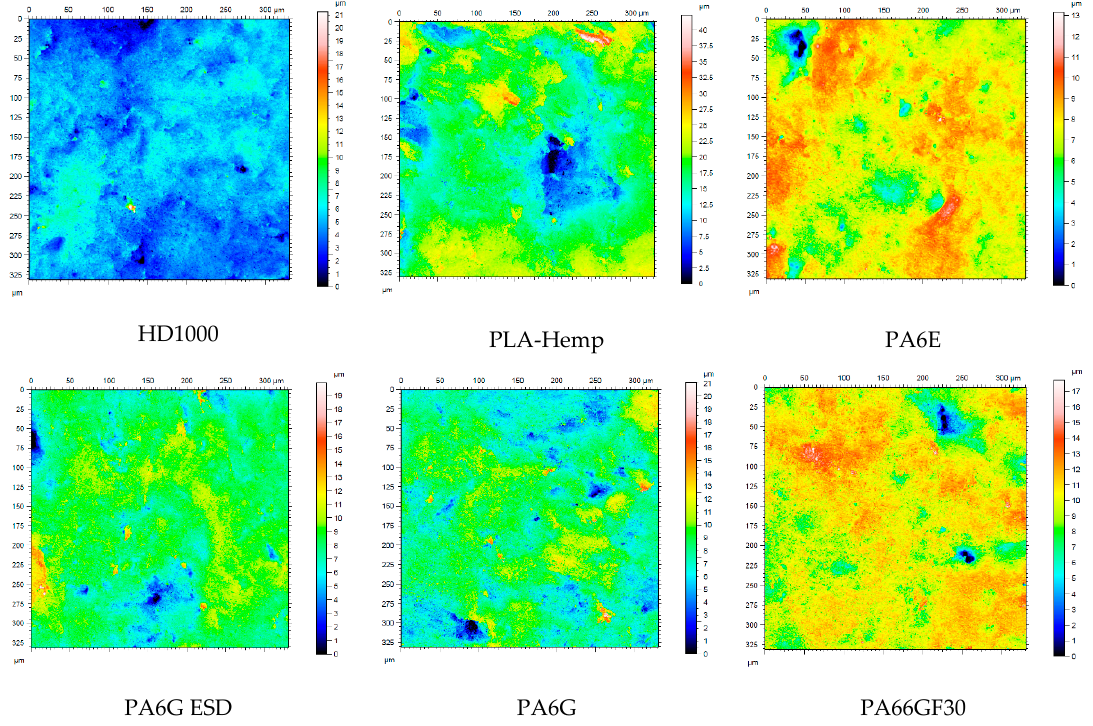
Figure 15. Microscopic visualization of the change of surface 3D topography of the tested materials in gravel slurry at position No.1 (Figure 3).